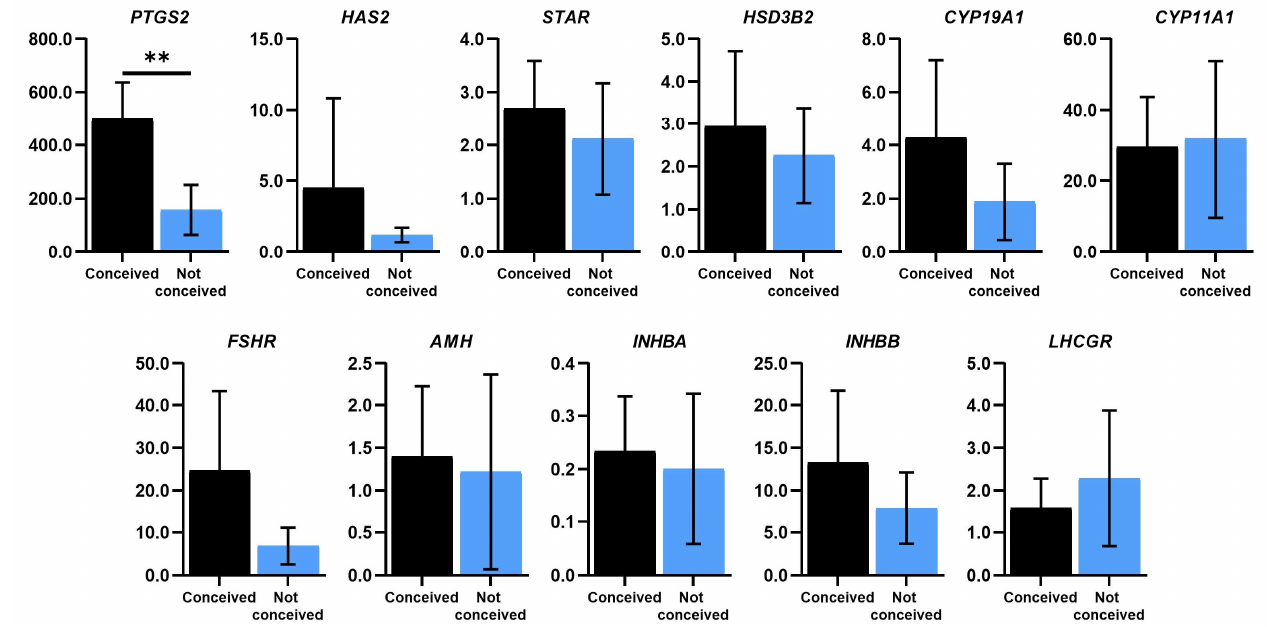
Figure 4. Real-time PCR analysis of genes related to ovarian follicle development and FSH response in cells of human follicular fluid sediment. Results are presented as mean ± standard deviation. In the conceived group, n = 6; in the not-conceived group, n = 6. ** p ≤ 0.01, based on the Mann–Whitney U test.